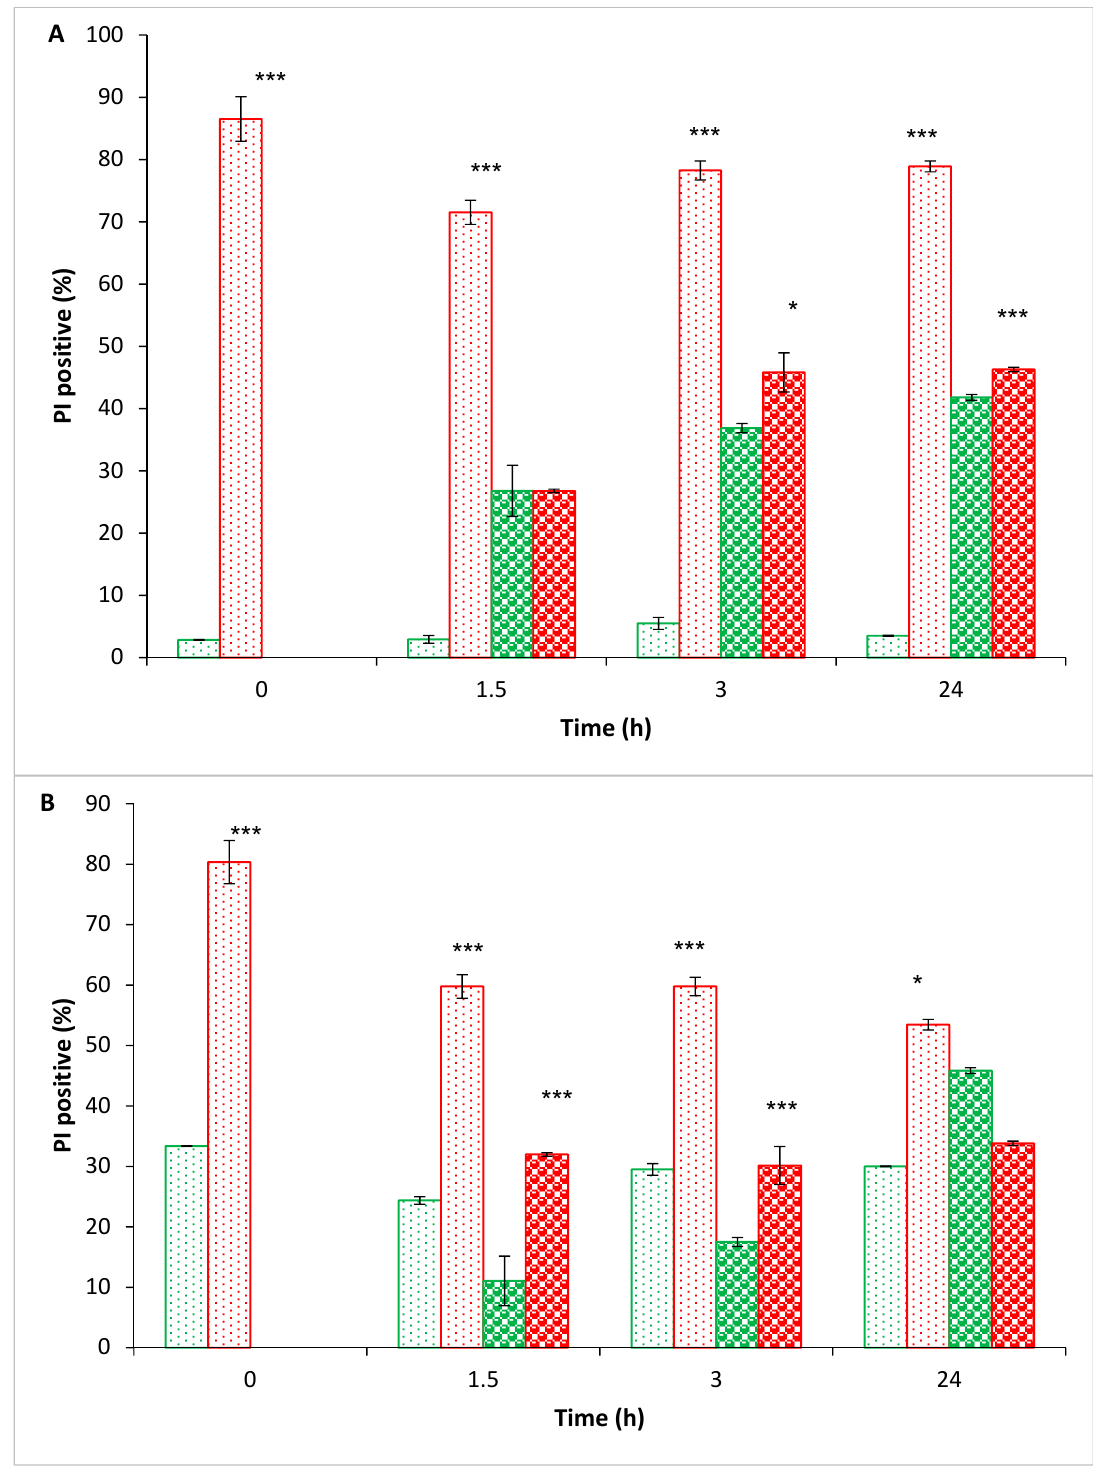
Figure 4. Membrane permeability of S. aureus ( A ) and P. putida F1 ( B ). PEF-treated bacteria which were diluted in BHI (1.5–24 h) (